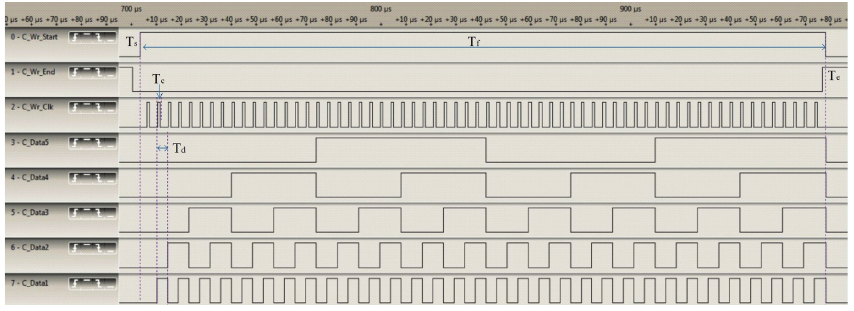
Figure 13: Data and Timing Waveform when CC2530 Writing to Multiplexer, via Salea16.